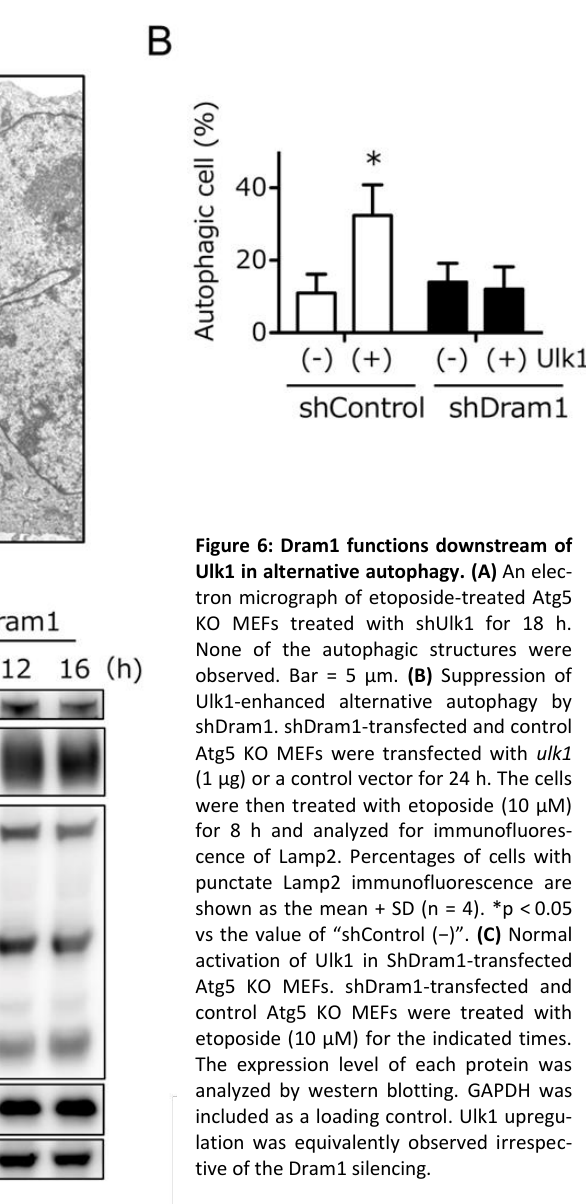
Figure 6: Dram1 functions downstream of Ulk1 in alternative autophagy. (A) An elec- tron micrograph of etoposide-treated Atg5 KO MEFs treated with shUlk1 for 18 h. None of the autophagic structures